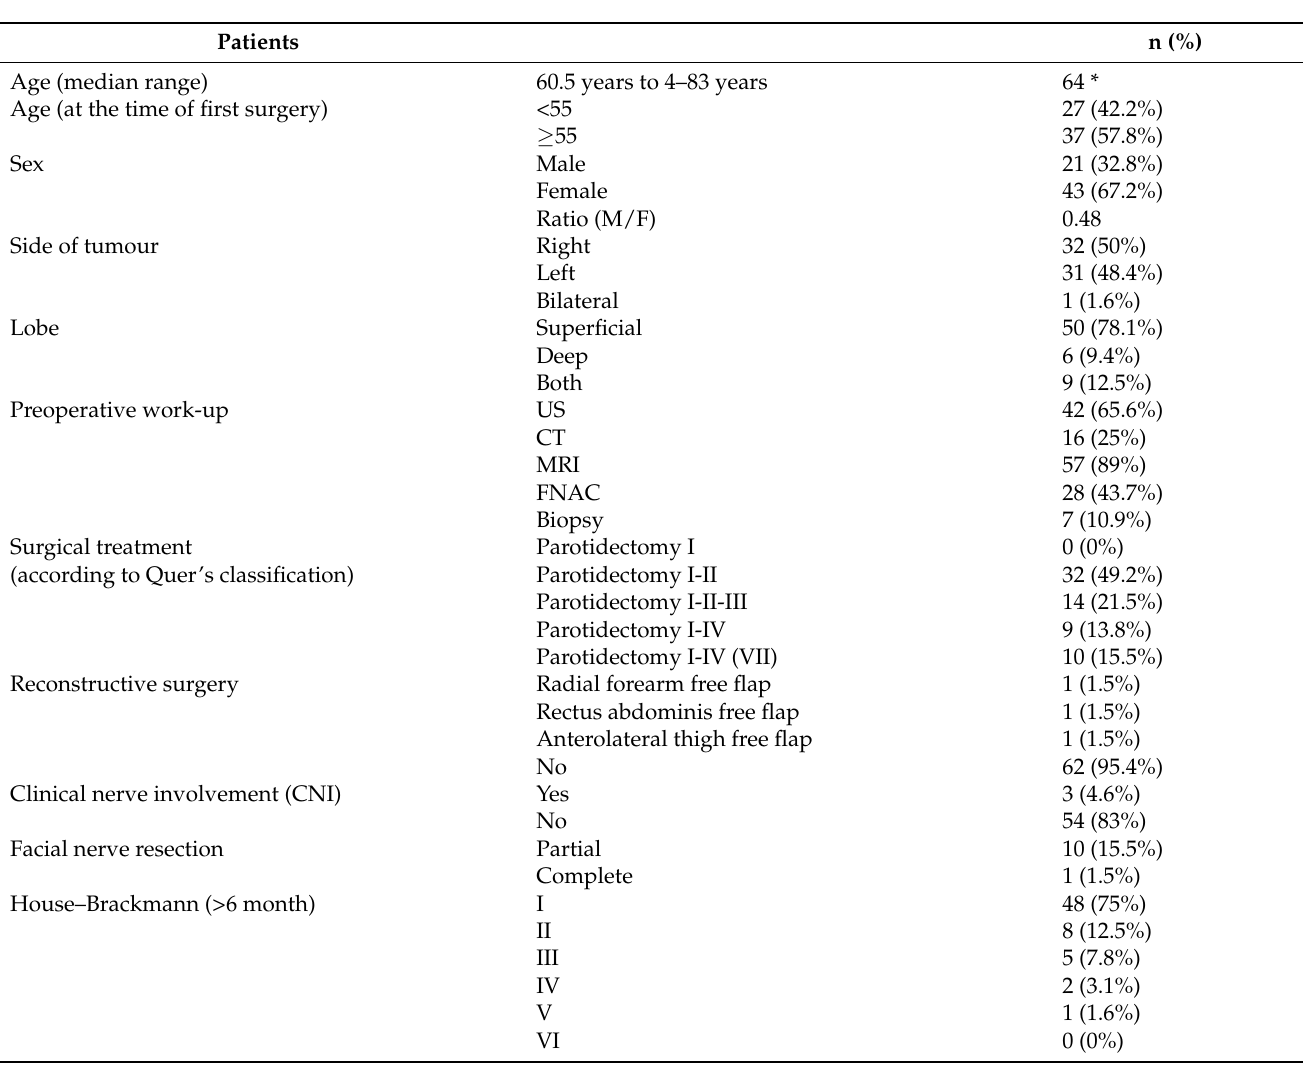
Table 1. Demographics and clinical